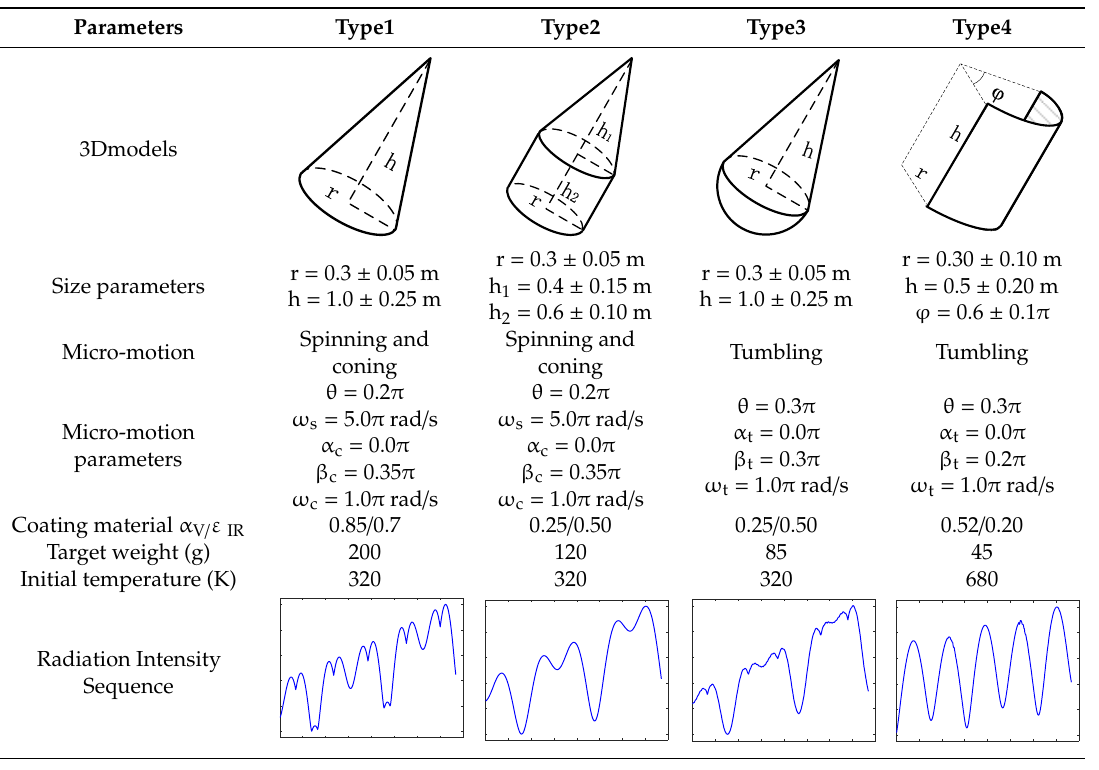
Table 1. Simulation parameters for four classes of spatial targets.